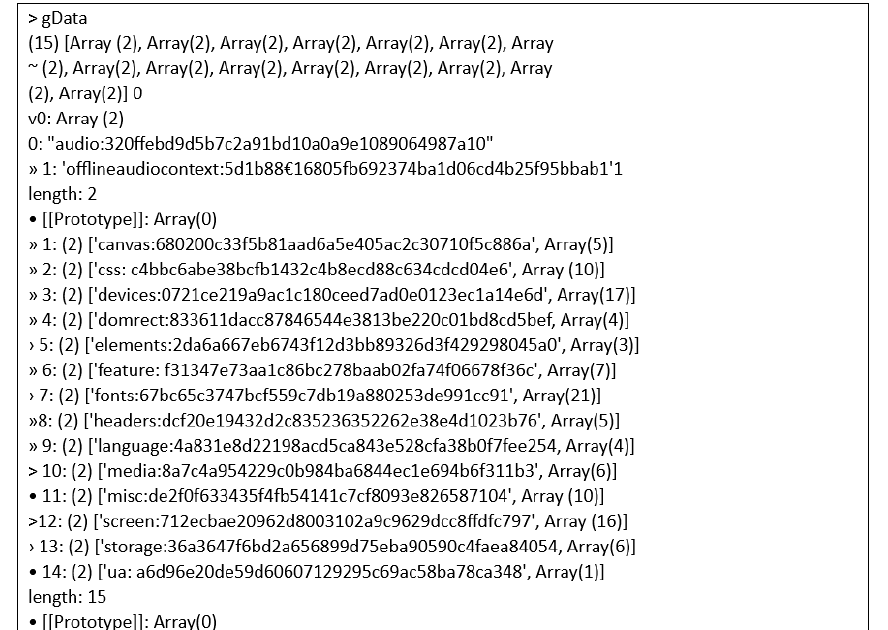
15 of 19 Figure 5. Snapshot of the website built.